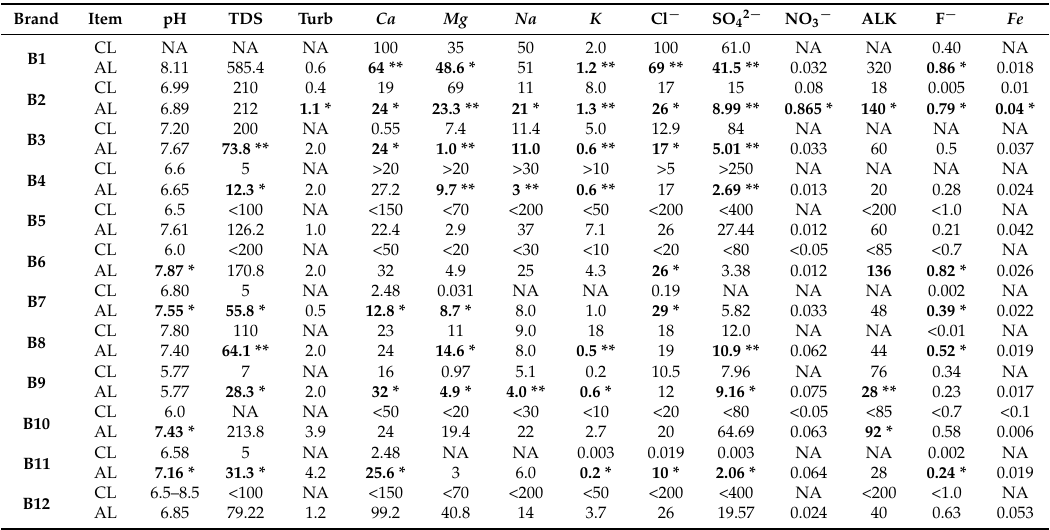
Table 5. Physico-chemical results (mean values) compared to claimed